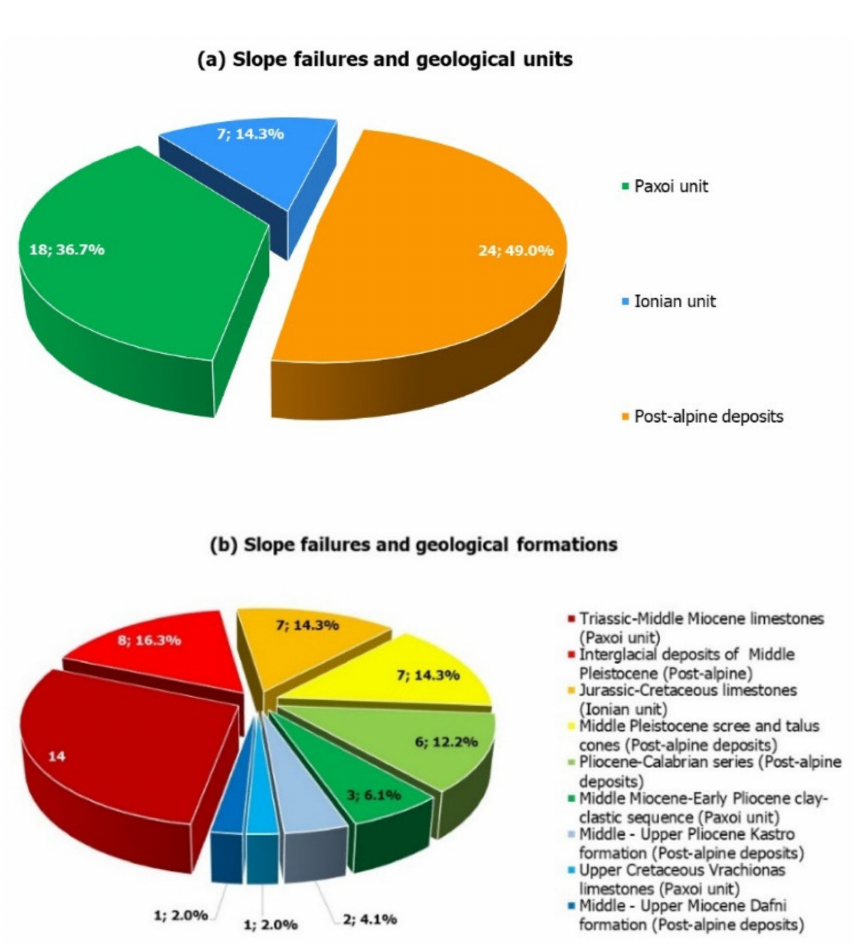
Figure 16. Pie charts showing the distribution of slope failures triggered by the 12 August 1953 mainshock and its 9 and 11 August foreshocks ( a ) in geological units and ( b ) in geological